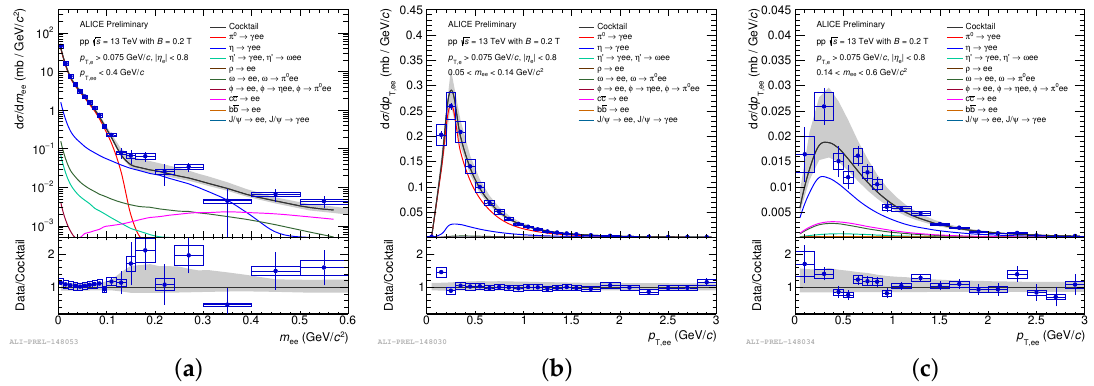
√ s = 13 TeV as a function of: ( a ) m ee for p T,ee < Figure 4. The dielectron cross section in pp collisions at 0.4 GeV/ c ( b ) p T,ee in the pion mass region ( c ) p T,ee in the η mass region with a single-electron selection of p T < 0.075 GeV/ c (blue points) compared to the hadronic cocktail (black line) and its different contributions (colored lines). The bottom panels show the ratio of data over